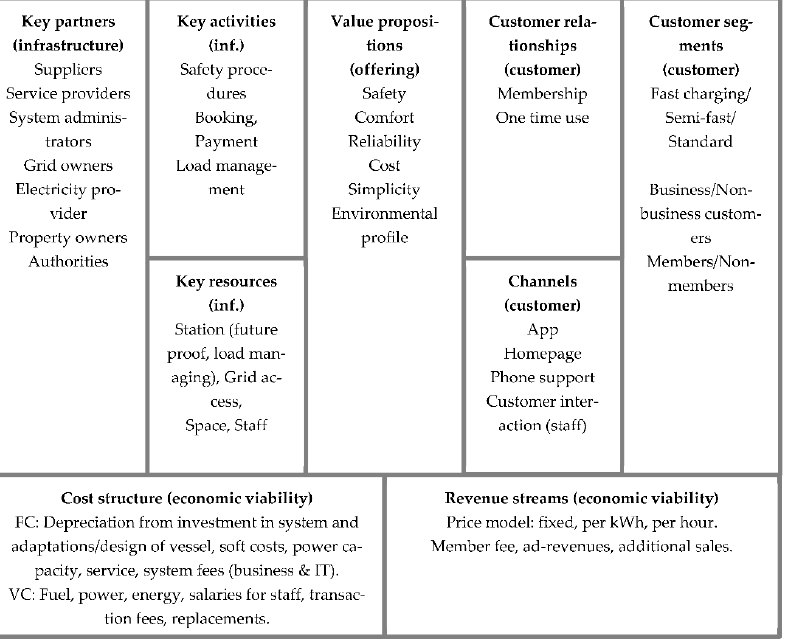
Figure 1. Key business model aspects of on board and in-terminal charging.